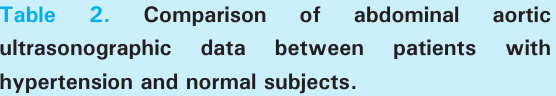
diastolic diameter; r, pearson correlation coefficient; Table 2. Comparison of abdominal aortic p, p-value calculated by t test; d-posterior, the ultrasonographic data between patients with displacement of posterior wall; ∆displacement, the hypertension and normal subjects. difference of the displacement of anterior and posterior Patients, wall; Dis, distensibility. P-value mean (SD) Intraobserver and interobserver variability for diameters, displacements ranged from 2.9% to 5.7%. Intraobserver and interobserver variability for the ε were 4.9% ± 2.3%, 6.1% ± 3.4%, respectively. Intraobserver and interobserver variability for the s were 5.7% ± 2.4% and 7.4% ± 1.5%,